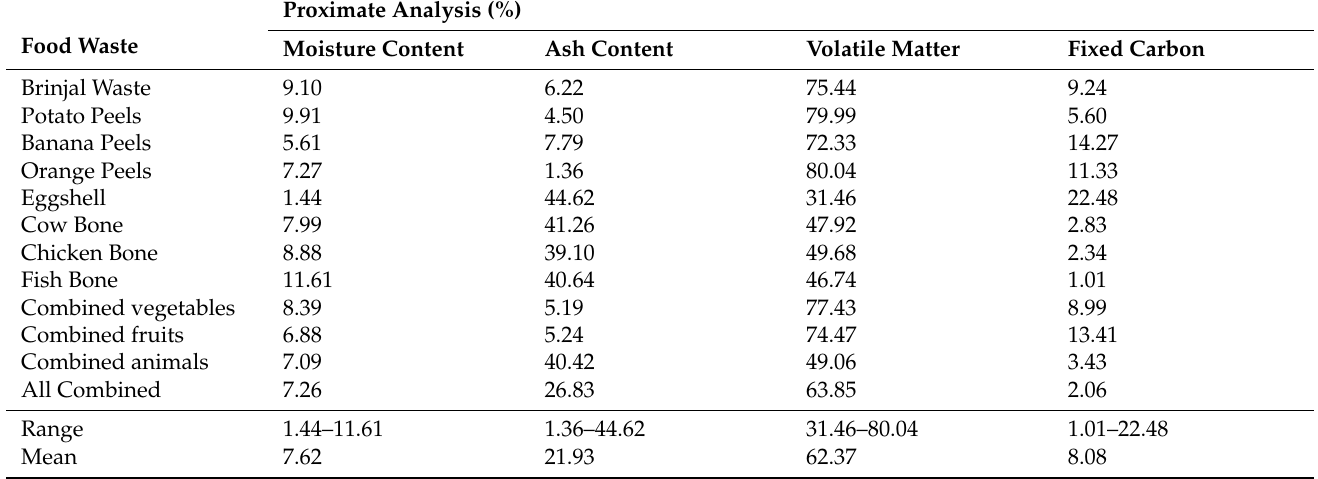
Table 1. Proximate analysis of different food